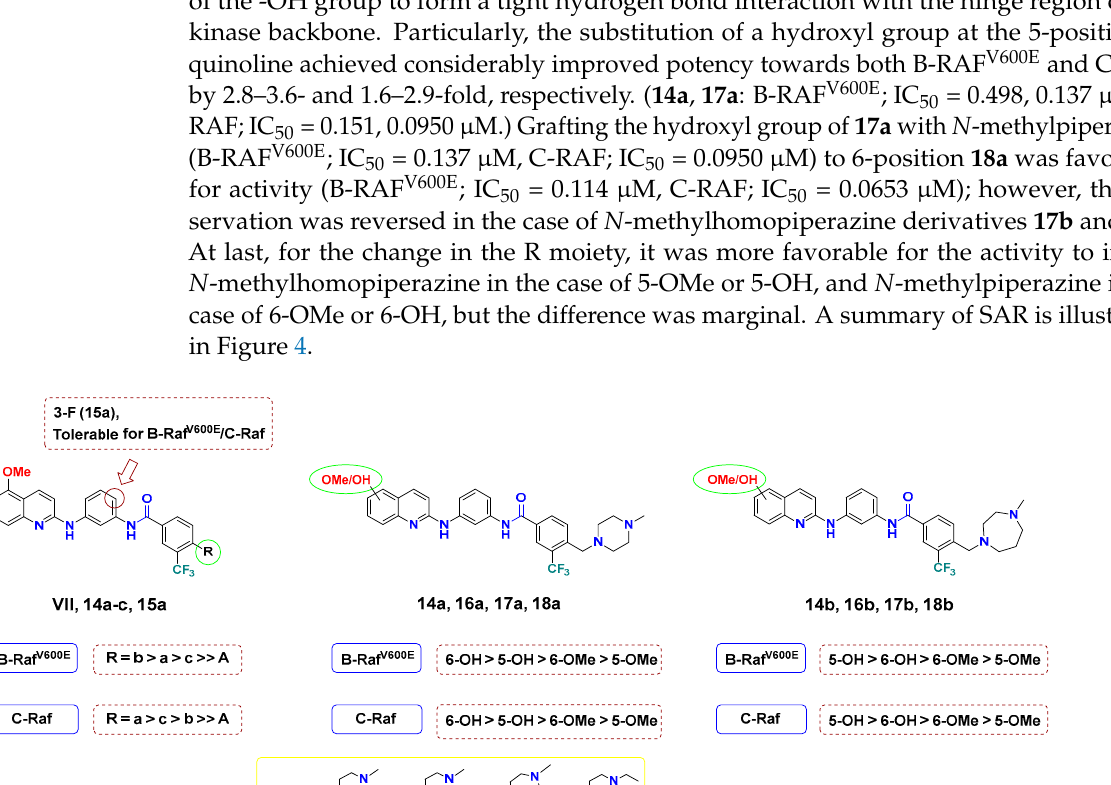
Table 2. In vitro kinase inhibitory activity (IC 50 , µM) of the most potent compounds, 17b and 18a, against B-RAF V600E/V600K and C-RAF. a, b, c .